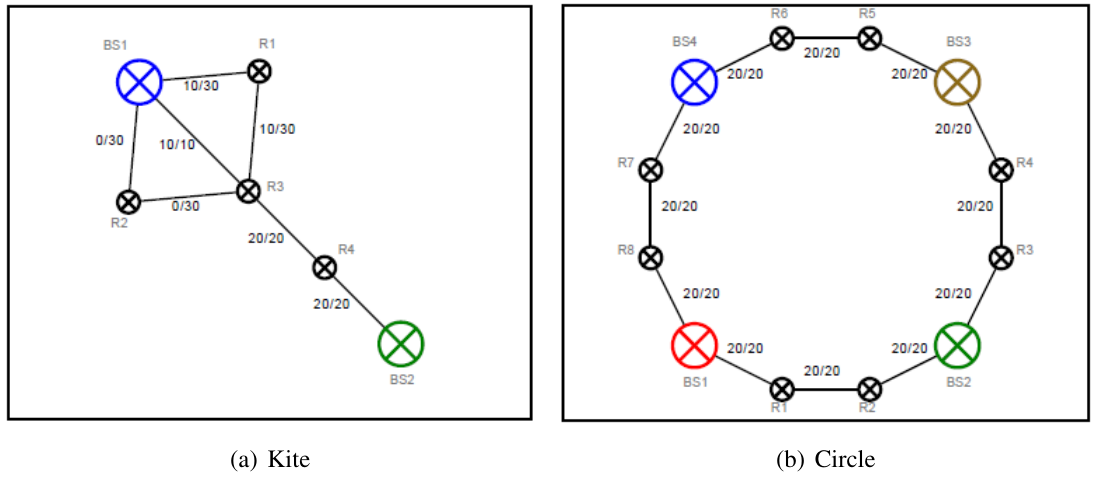
Figure 3. Case studies of local